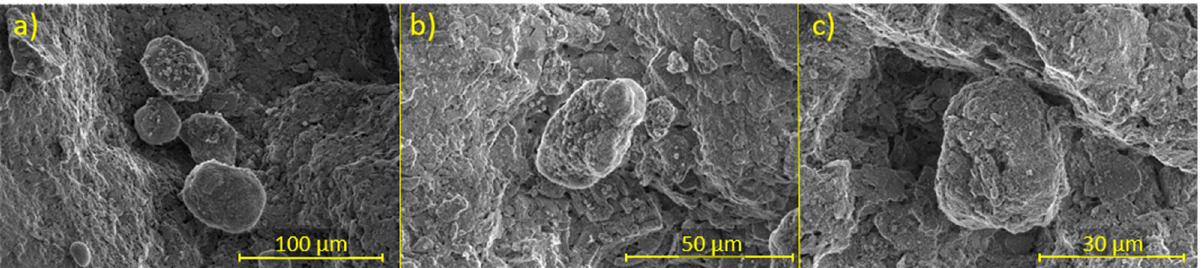
Figure 14. Cryo-SEM images of dry water particles on coarse sand particle surfaces after mixing. Magnifications were as follows: ( a ) 1500 ×, ( b ) 3500 × and ( c ) 5000 ×.